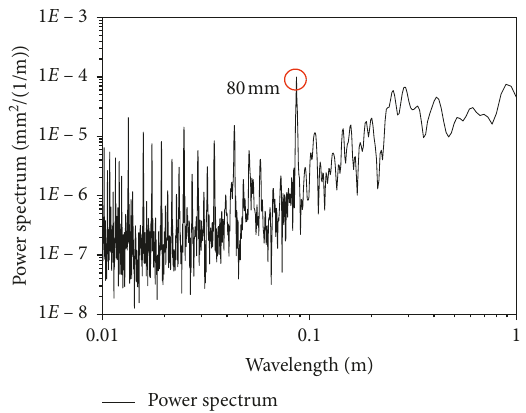
Figure 6: Power spectrum for rails with short-wavelength